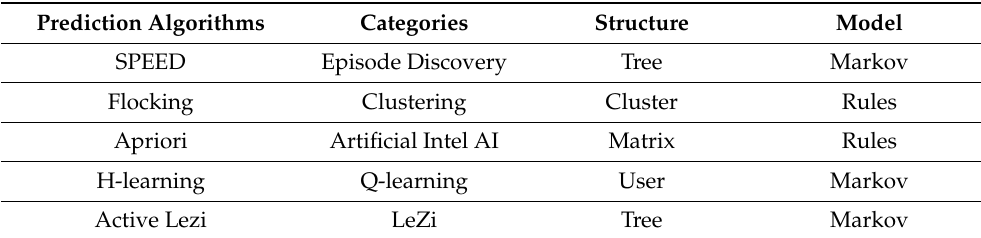
Table 4. Prediction Algorithm Categories. Prediction Algorithms Categories Structure